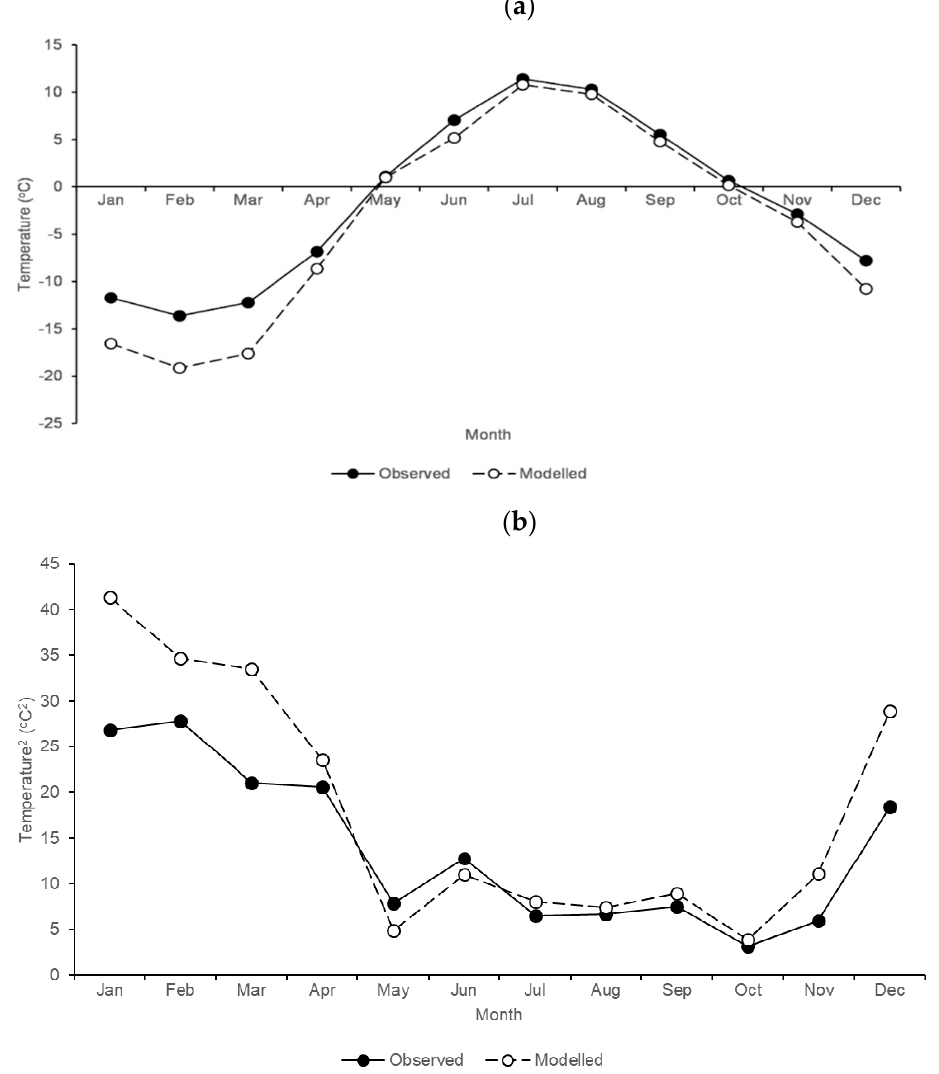
Figure 4. Comparison between the observed monthly 10 cm soil temperature and the predicted values from the CanESM2 and NCEP models for: ( a ) mean; ( b ) variance.